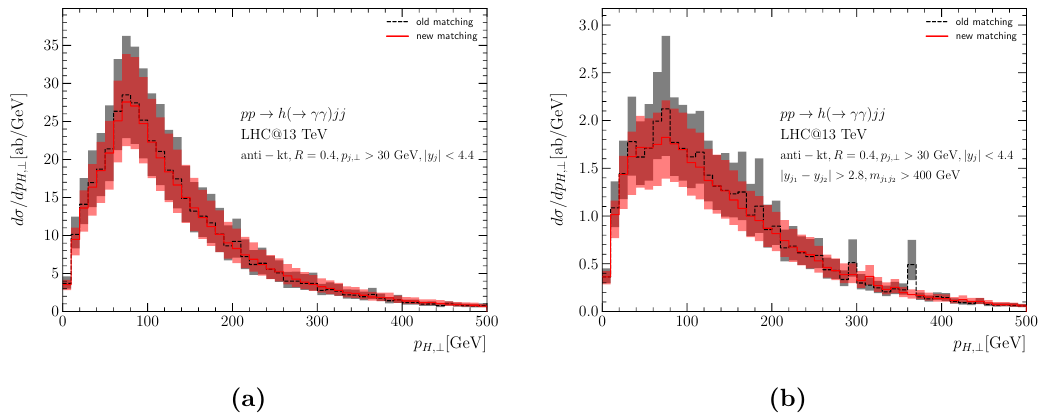
Figure 6. Comparison of the new matching procedure to previous HEJ results obtained in [18]. The panels show the transverse momentum distributions of the Higgs boson for (a) inclusive cuts and (b) VBF